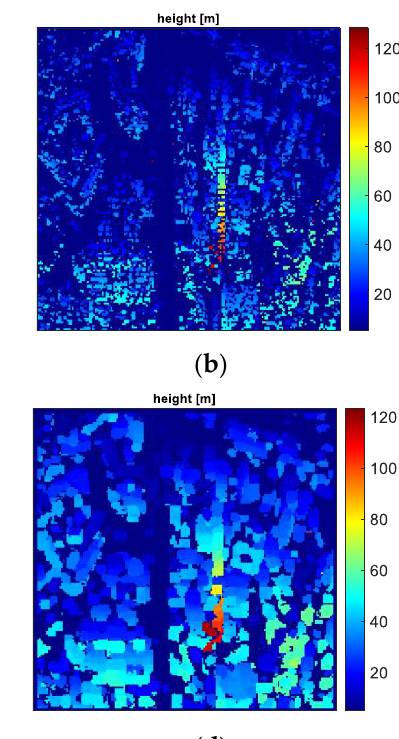
Figure 7. Images of Jolly Hotel, Naples, Italy. ( a ) Optical image and ( b ) SAR image (Copyright DLR 2012 – 2014).